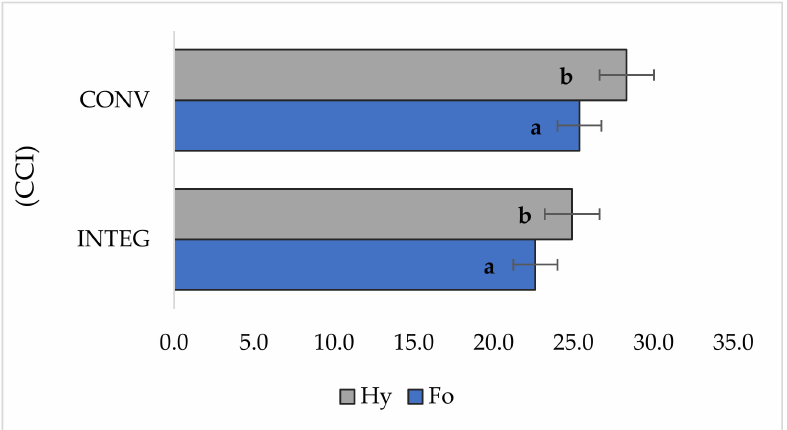
Figure 4. Relative chlorophyll content depending on cultivars and cropping systems. The presence of different lowercase letters indicates a statistical difference between means (Tukey’s Test, p = 0.05). INTEG—integrated cropping system, CONV—conventional cropping system, Fo—cv. Formacja, Hy—cv.